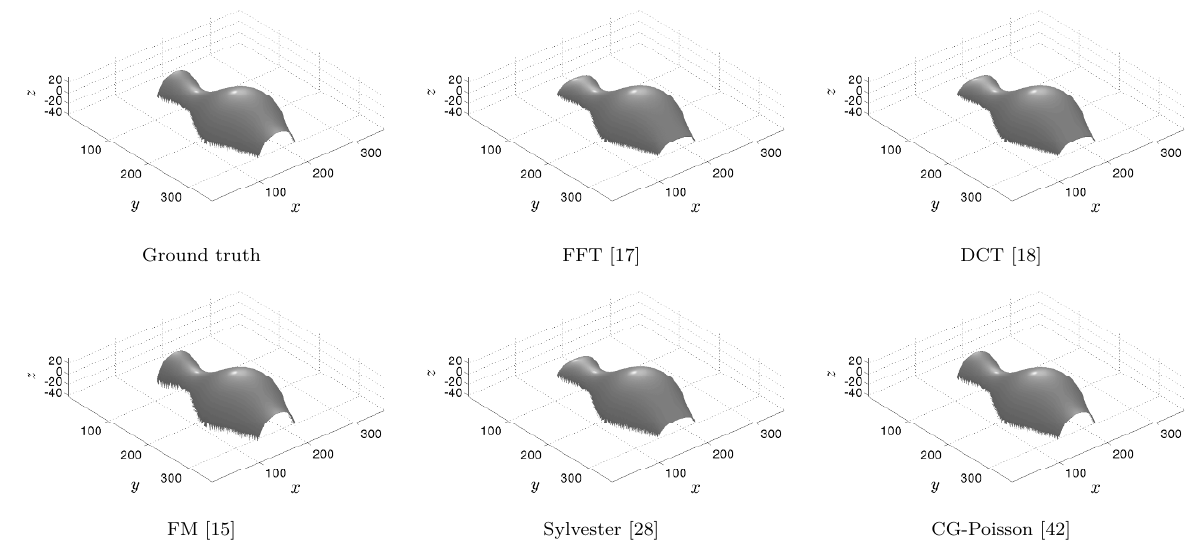
Fig. 9 Results on the “Vase” dataset; see Table 4.